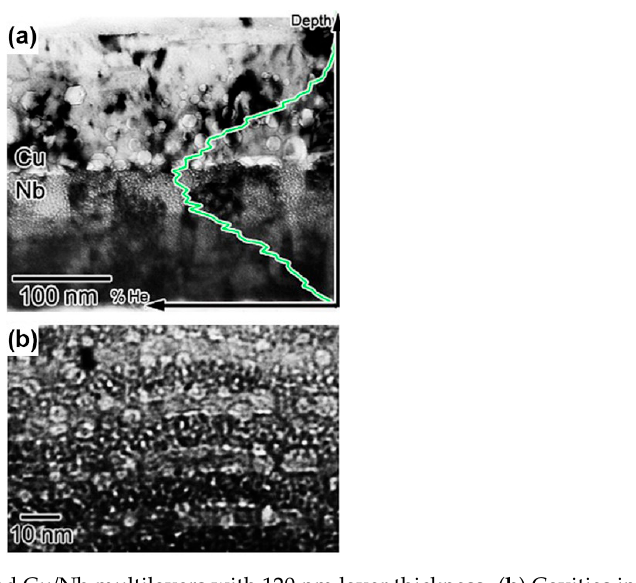
Figure 13. ( a ) Cavities in irradiated Cu/Nb multilayers with 120 nm layer thickness. ( b ) Cavities in He ion irradiated Cu/Nb multilayers with 5 nm layer thickness [46].